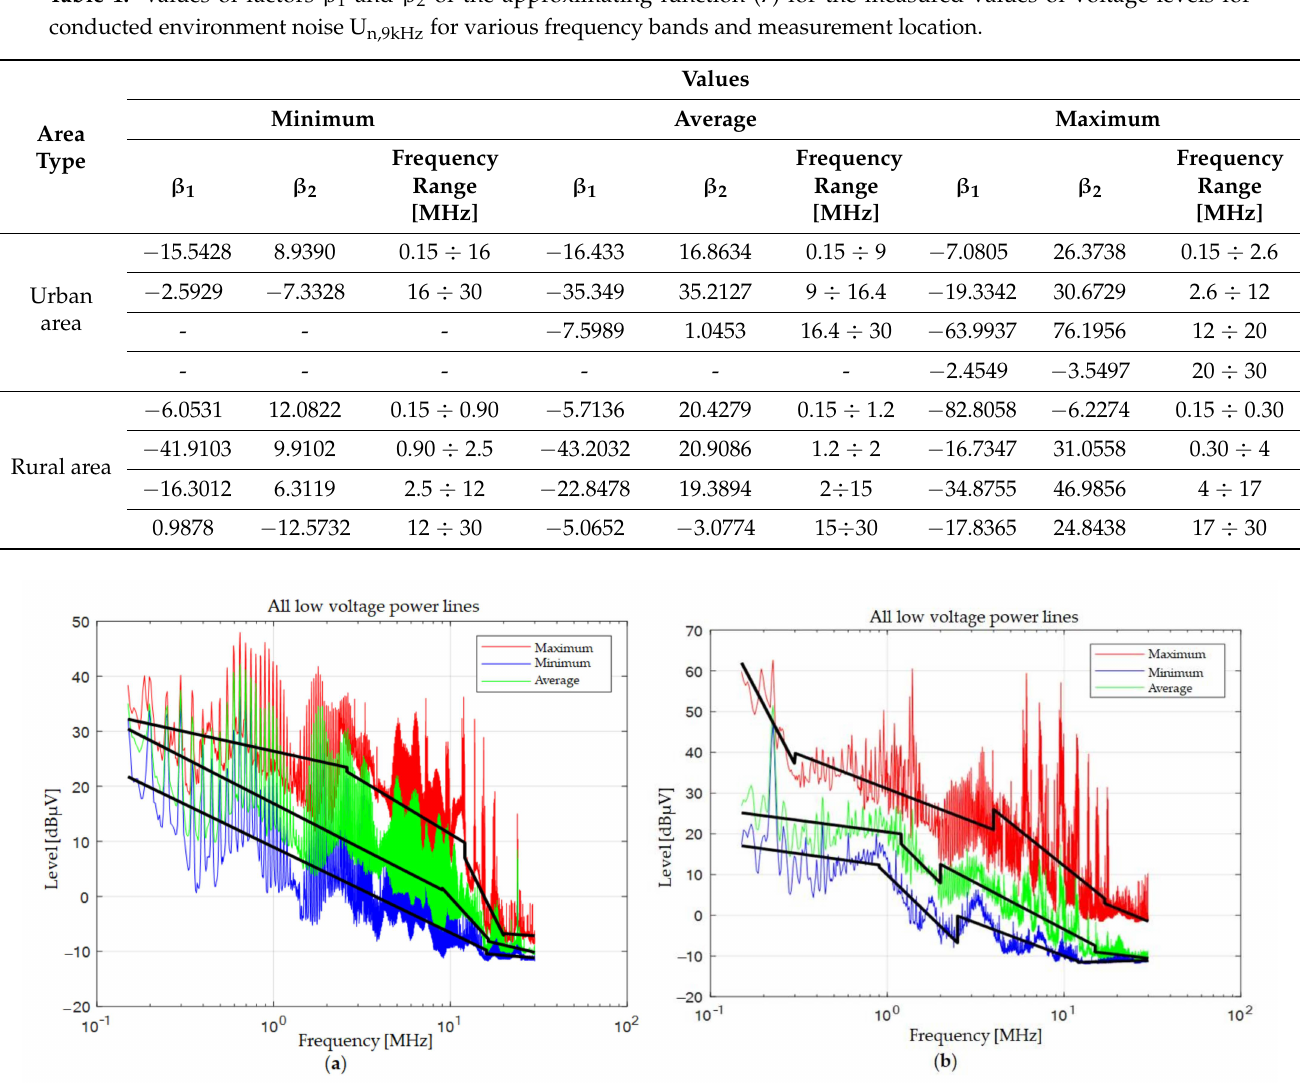
Figure 4. Maximum (red), minimum (blue) and average (green) values, together with functions to approximate the conducted environmental noise level U n,9kHz measured in the frequency range from 150 kHz to 30 MHz within a 24-h cycle on all low voltage power lines: L1, L2, L3 and N in an urbanized ( a ) and rural area ( b